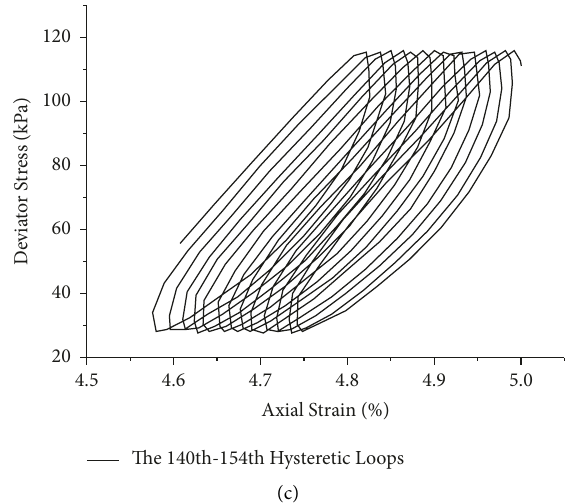
� 30kPa, | σ � 115kPa. (a) The 40 th –50 th hysteretic loop curves. (b) The 90 th –100 th hysteretic 3 1 – σ 3 | max